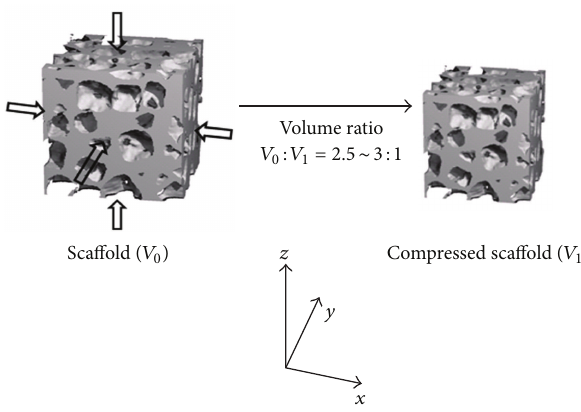
Figure 2: Schematic diagram of the preparation of an auxetic scaffold (compressive volume ratio = 2.5 ∼